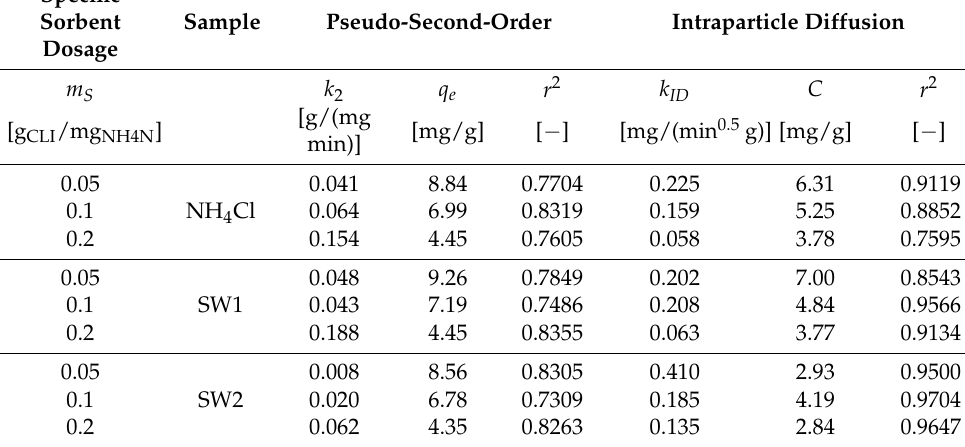
Table 8. Coefficients of the sorption kinetics according to the PSO and ID models of CCP 20